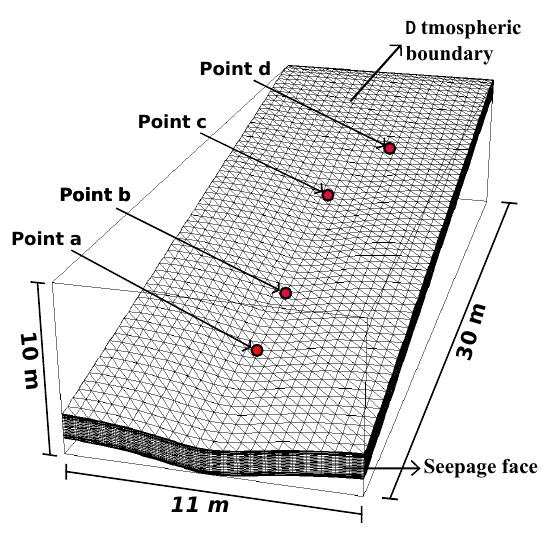
Figure 2. The 3-D numerical grid for the LEO landscape. Points a, b, c, and d are the locations where samples were extracted during the experiment for subsequent laboratory